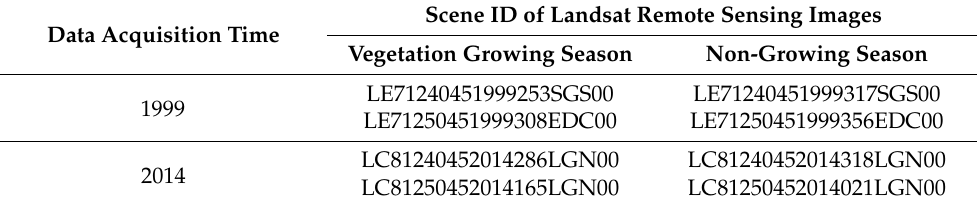
Table 1. Scene ID of Landsat remote sensing images in study